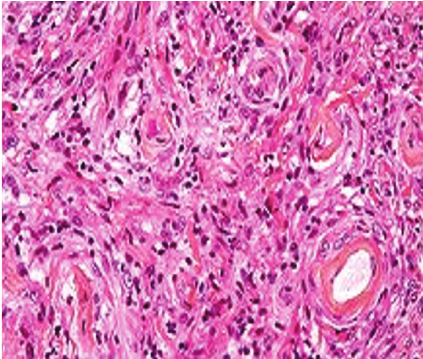
Figure 4: Histopathology slide: histopathologically showing char- acteristic whorling suggestive of